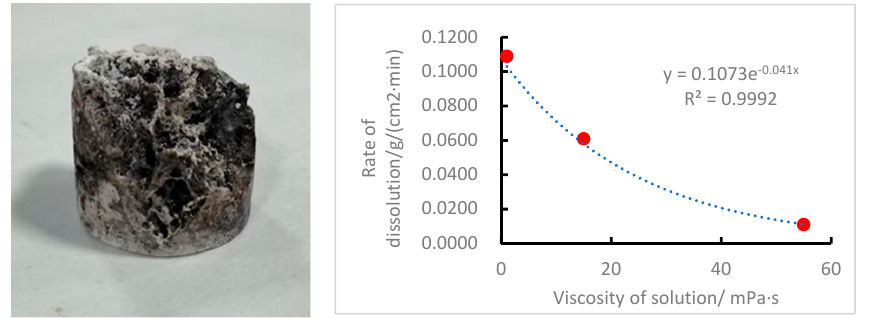
Figure 5. Dissolution of rock samples in solutions of different viscosities within 30 min. ( Left ) salt-dissolved morphology of low-viscosity fracturing fluid; ( Right ) Influence curve of solution with a different salt concentration on dissolution rate.